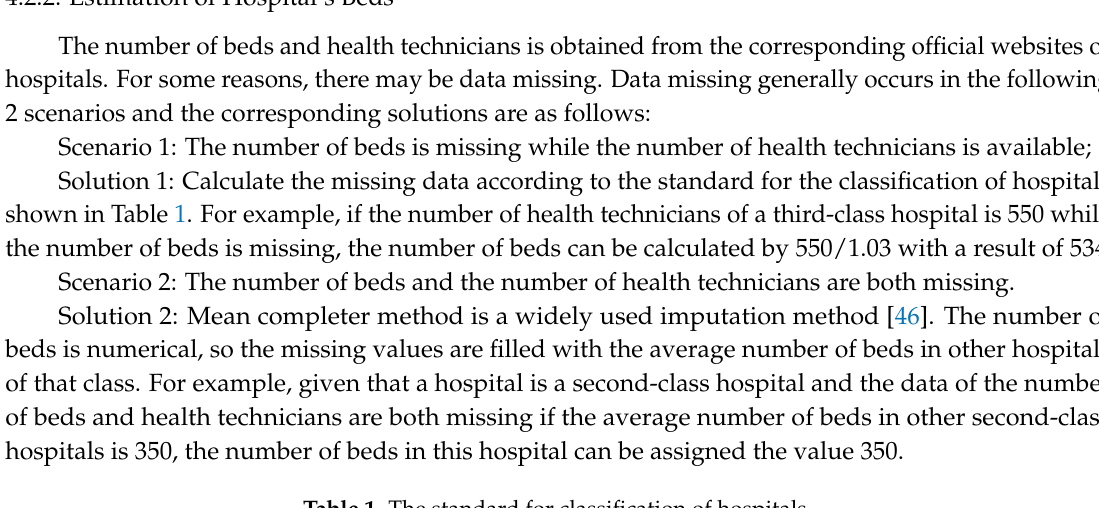
Table 1. The standard for classification of hospitals.